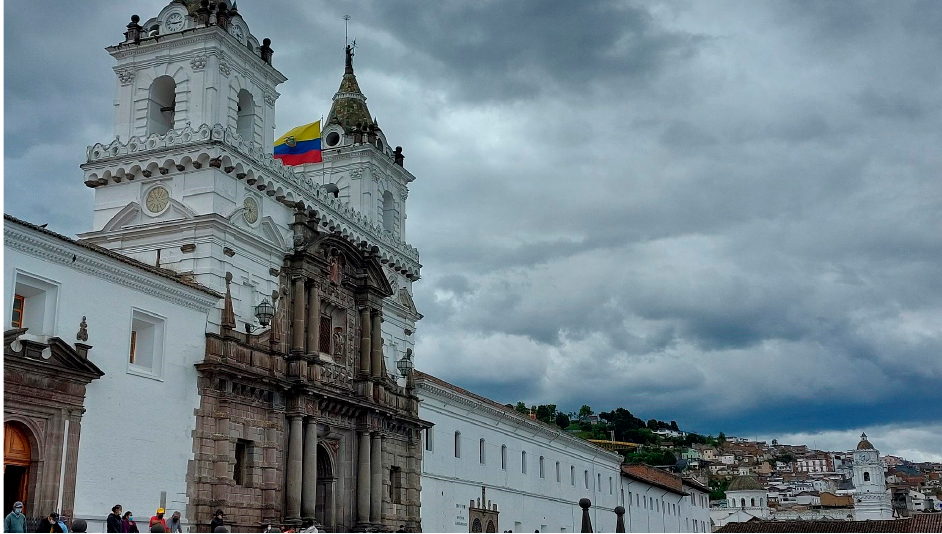
Figure 3. Church and Convent of San Francisco, Quito. Code: QU-1. (2022).